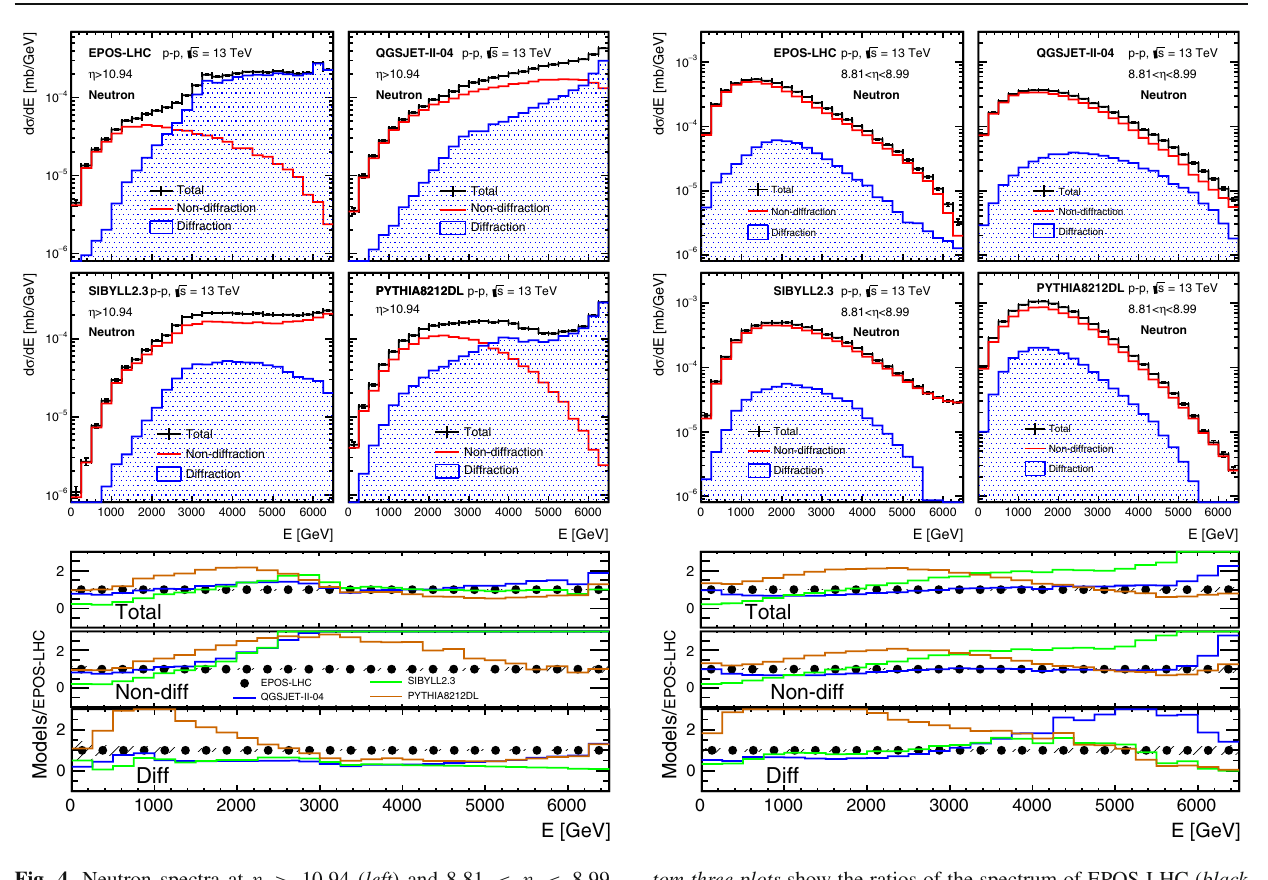
Fig. 4 Neutron spectra at η > 10 . 94 ( left ) and 8 . 81 < η < 8 . 99 ( right ) ( top four panels in each set ). These are generated by EPOS- LHC, QGSJET-II-04, SYBILL 2.3, and PYTHIA 8212DL, respec- tively. The total neutron spectra ( black ) were classified by nondiffrac- tion ( red ) and diffraction ( blue ) according to MC true flags. The bot-